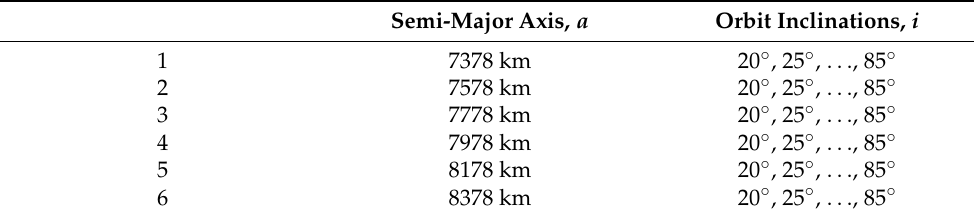
Table 2. Orbit characteristics for the ephemeris